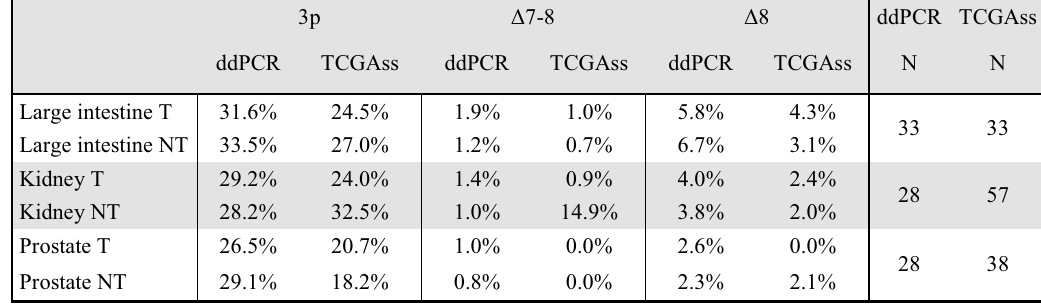
Table 4. Comparison of HNF1B ASVs expression measured by our ddPCR approach with TCGAss. Numbers represent the percentage of each individual variant. ddPCR based expression is related to the overall HNF1B mRNA expression (calculated as the sum of canonical exon 3 and 3p variants), TCGAss expression is calculated as a 100-PSI/percent splice in; see methods). Each line represents data from corresponding T and NT datasets. T tumour tissue, NT non-tumour tissue, N number of samples in